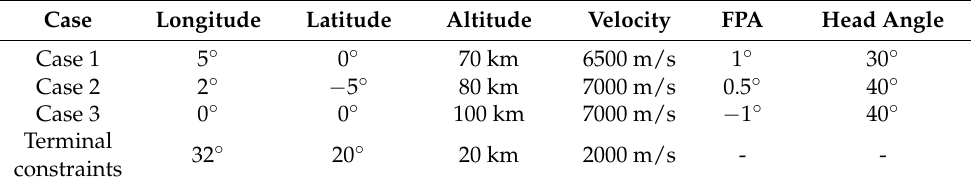
Table 2. The setting of the